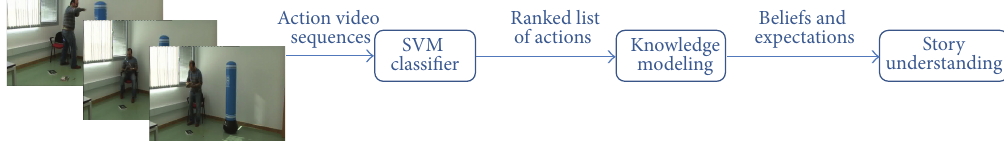
Figure 2: Stages involved in the proposed solution for human action